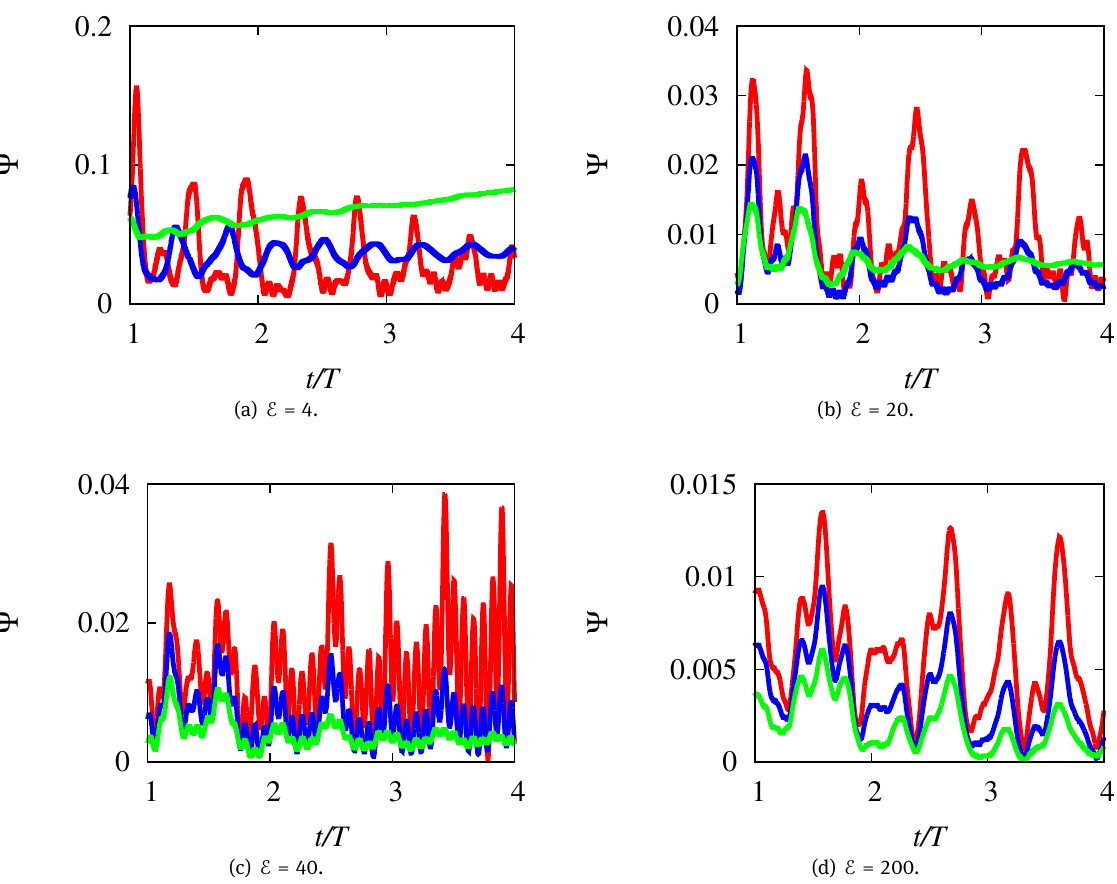
Figure 2: Time history of the deformation energies for different values of E at R = 15 (green curve), R = 50 (blue curve) and R = 100 (red